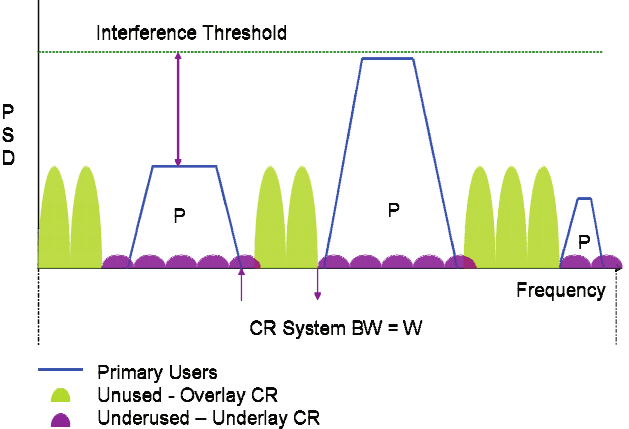
Figure 49. Identification of primary users, unused and underused spectral region